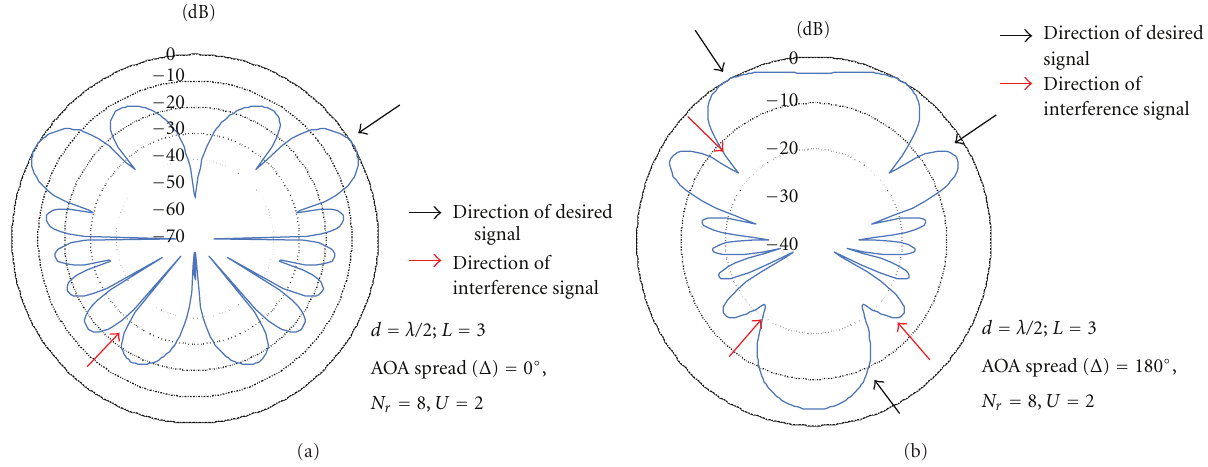
Figure 10: FDAAA Radiation pattern change from Δ = 0 ◦ to Δ = 180 ◦ where nonzero array gain appears in should-be-null direction.